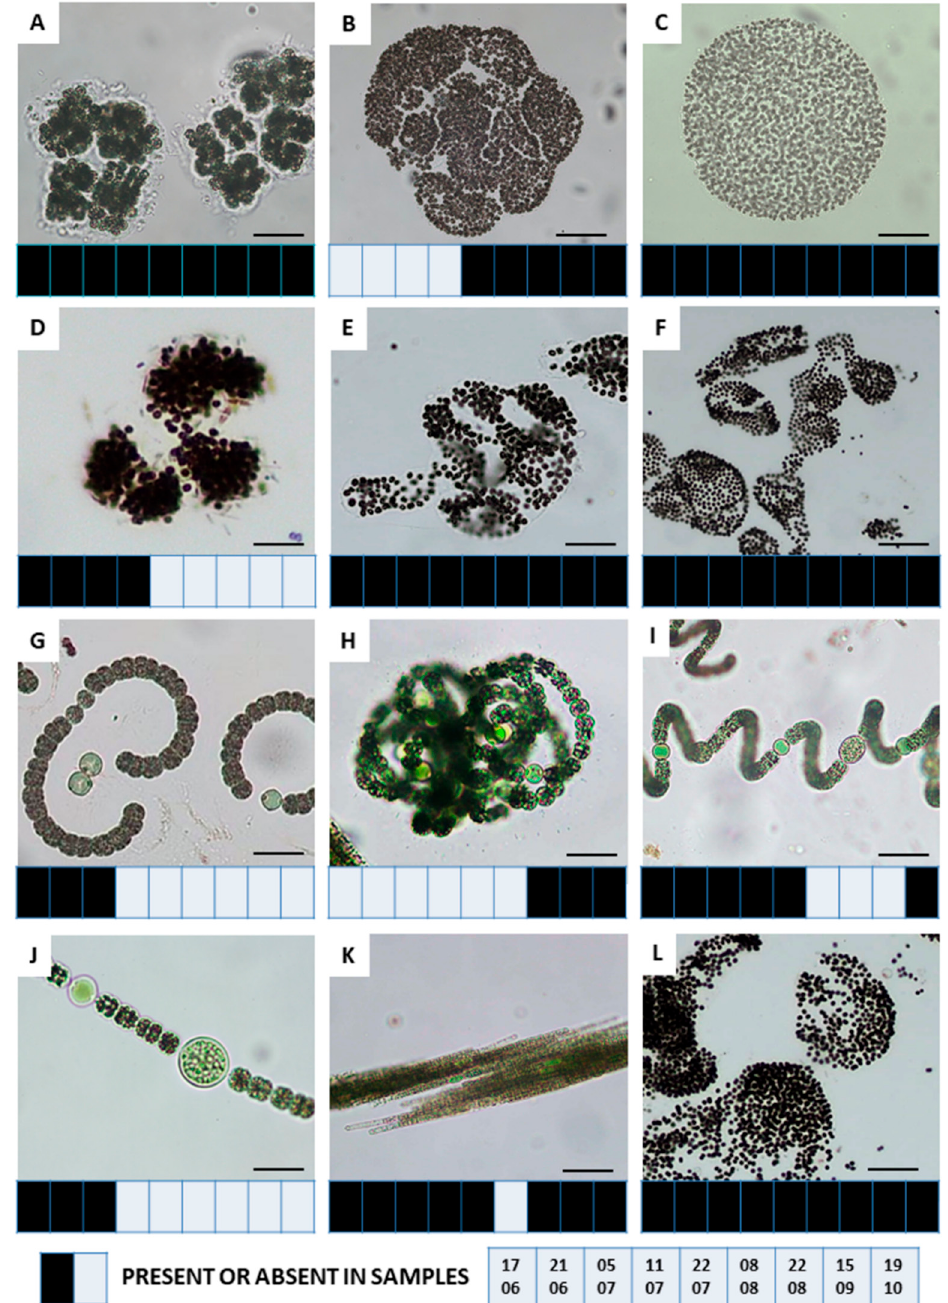
Figure 6. The cyanobacteria taxa and their presence in samples from the Stryk ó w artificial